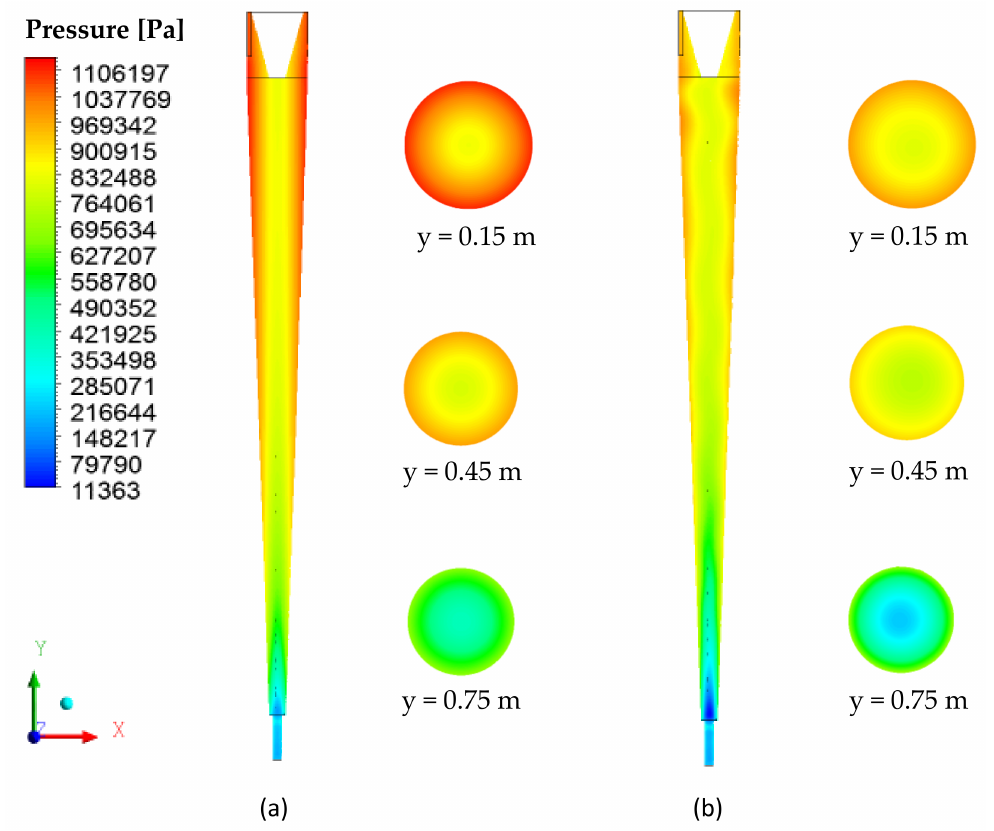
Figure 5. Pressure field on the xy and xz planes. ( a ) Conventional cyclonic separator and ( b ) filtering cyclonic